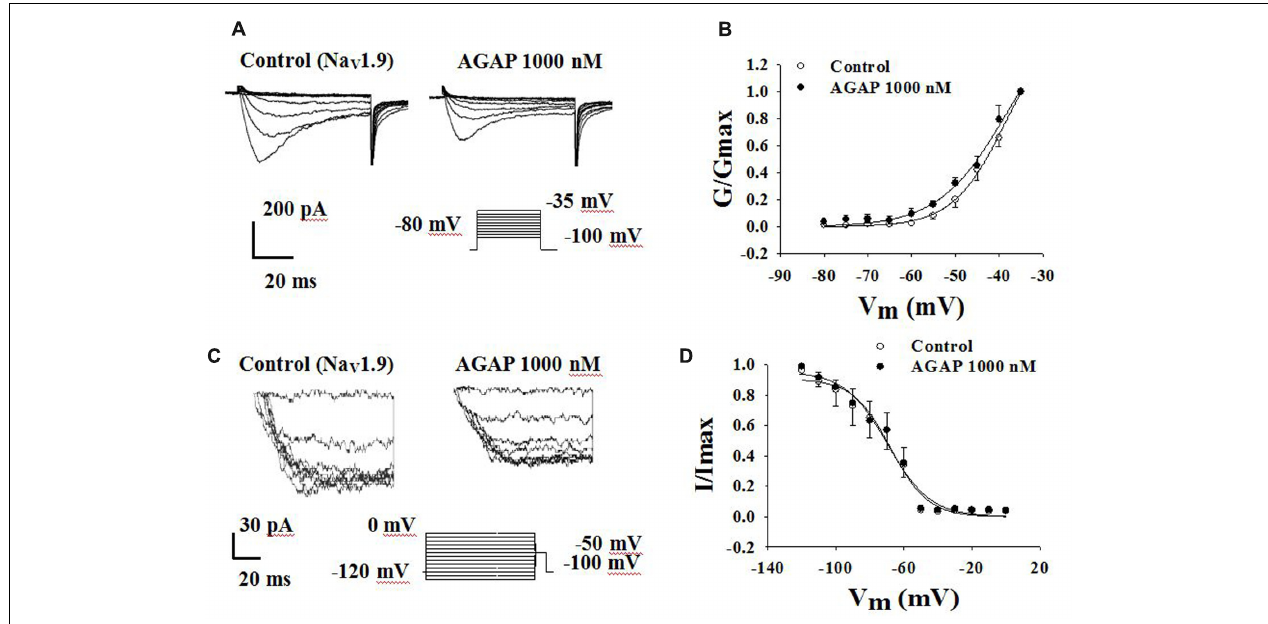
FIGURE 9 | Effect of AGAP on the dynamic function of Na V 1.9 channels. 1000 nM AGAP did not significantly affect the voltage-dependence of channel activation or steady-state inactivation. (A,B) Effect of AGAP on steady-state activation kinetics of Na V 1.9 currents. V 1 / 2 was − 38.4 ± 1.5 mV in control conditions and − 38.2 ± 3.7 mV in the presence of 1000 nM AGAP. Slope factors were 6.1 ± 0.5 and 7.8 ± 1.1 mV, respectively ( n = 7). (C,D) Steady-state inactivated of Nav1.9 in the absence and presence of AGAP. V 1 / 2 for inactivation was − 67.9 ± 2.2 mV in control conditions and − 69.6 ± 2.5 mV in the presence of 1000 nM AGAP. Slope factors were − 11.0 ± 1.8 and − 12.5 ± 2.0 mV, respectively ( P > 0.05, P values are from unpaired t -test. n =